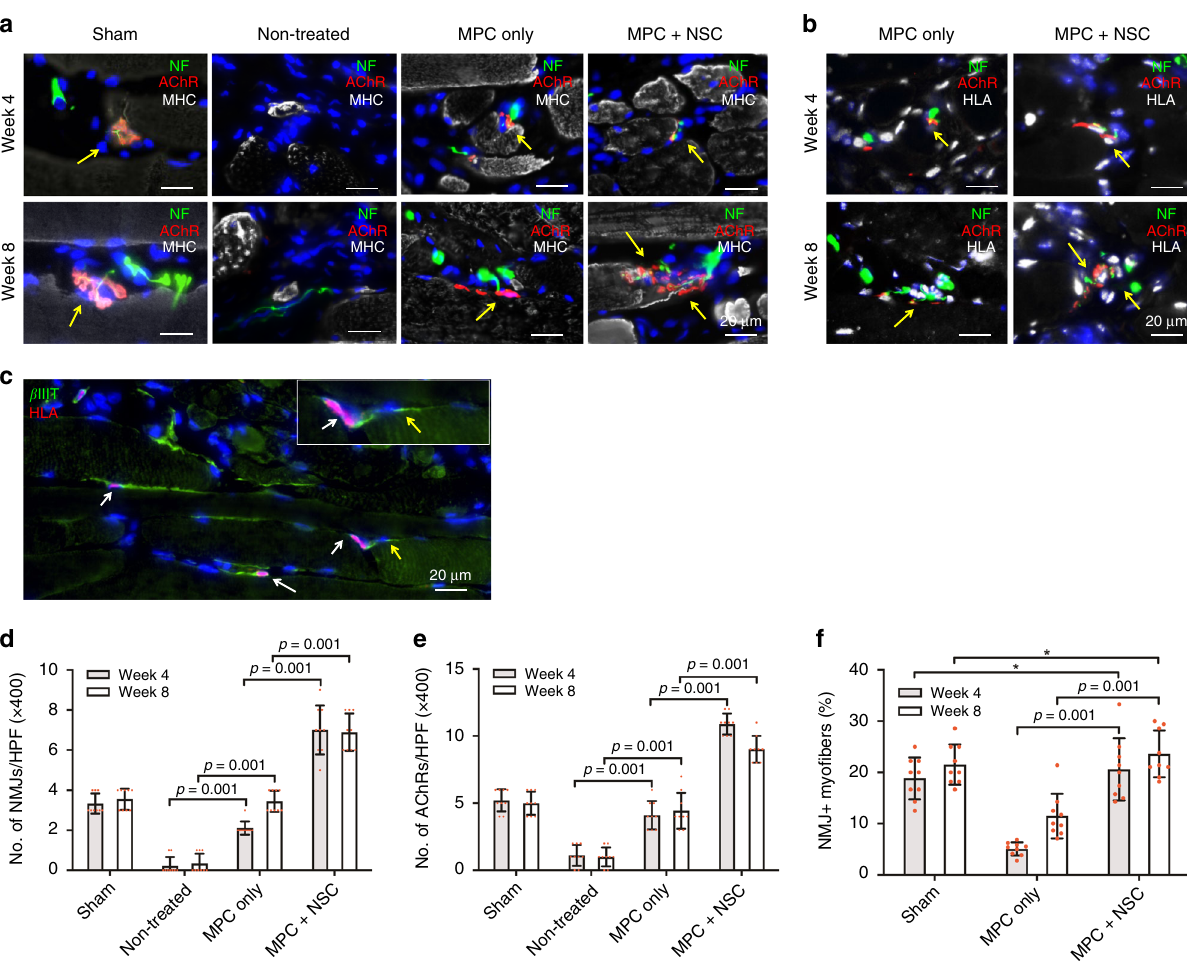
Fig. 7 Neural integration with 3D bioprinted skeletal muscle constructs. a, b Immuno fl uorescence for a NF (green)/AChR (red)/MHC (white) and b NF (green)/AChR (red)/HLA (white) of injured TA muscles at 4 and 8 weeks after implantation. c Immuno fl uorescence for β IIIT (green)/HLA (red) of the MPC + NSC constructs at 8 weeks after implantation. d – f Quanti fi cation of d number of NMJs per HPF ( n = 3 per group and time point, three random fi elds per sample) and e number of AChRs per HPF ( n = 3 per group and time point, three random fi elds per sample). f NMJ + myo fi bers (%) ( n = 3 per group and time point, three random fi elds per sample, *no signi fi cance). HPF high power fi eld at ×400. All data are represented as mean ± SD. The p -values by two-way ANOVA followed by Tukey ’ s test are